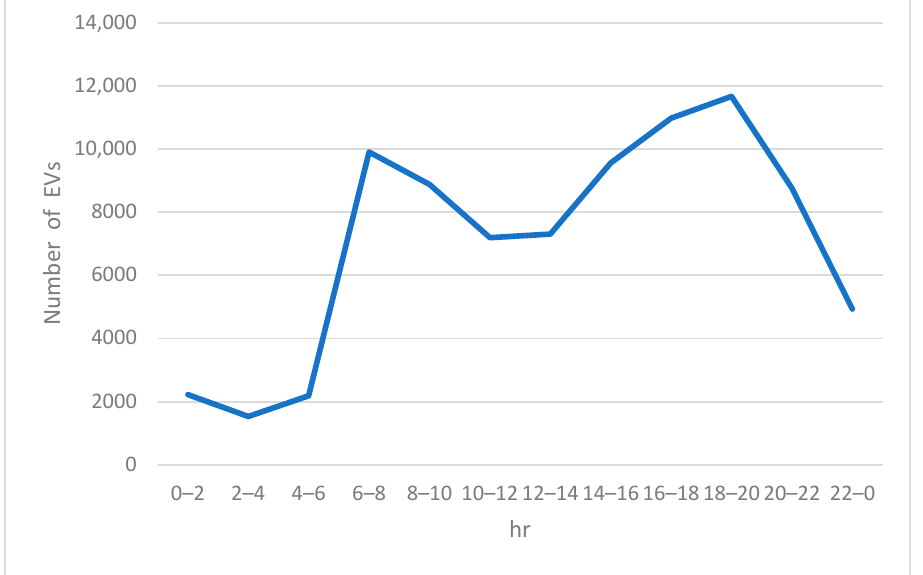
Figure 5. Volume of emergency missions performed by the UAVs within a day. Figure 6 shows the number of charging requests for UAVs within a day. It can be seen that the counts of charging requests were directly proportional to the number of missions. Accordingly, the charging requests increased signi fi cantly during morning and evening peak hours because the UAVs consumed a lot of electricity while continuing to deliver goods during busy periods.